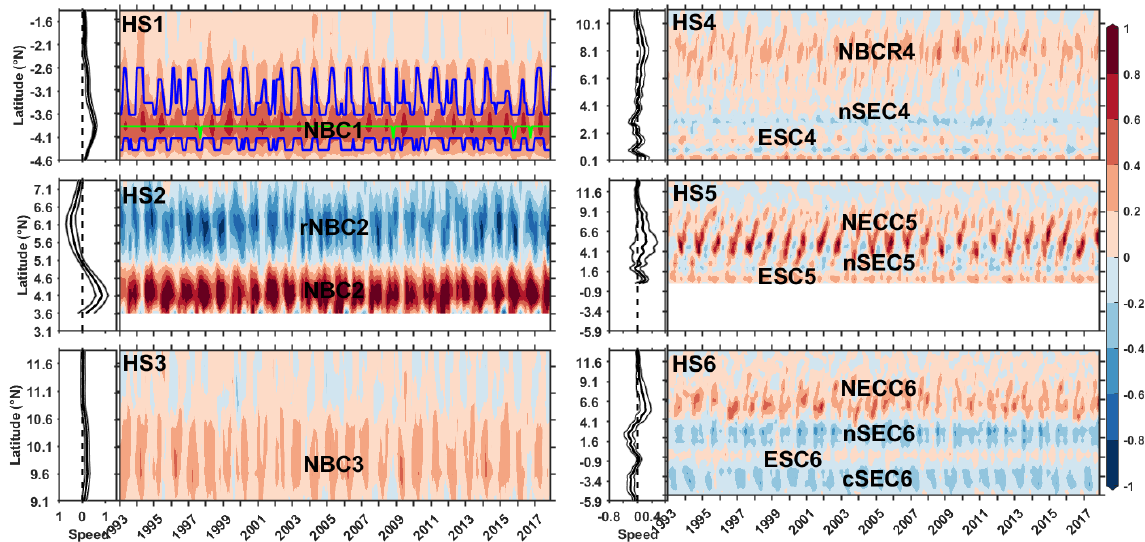
Figure 3. Hovmöller diagrams (1993 to 2017) of the cross-sectional current components (ms − 1 ) for HS1, HS2, HS3, HS4, HS5, and HS6. The time average over the section is shown (thick lines), framed by the corresponding standard deviation (thin lines), on the left side of each panel. The color shading shows the northward and eastward (red) or southward and westward (blue) direction of the cross-current. Acronyms are listed in Table A1. The numbers next to the acronyms represent the number of the horizontal section. The green line in the HS1 plot indicates the time series of the maximum velocity of the cross-sectional current (NBC) and is framed by the time series of the maximum velocities divided by 2 (blue lines) over 1993–2017